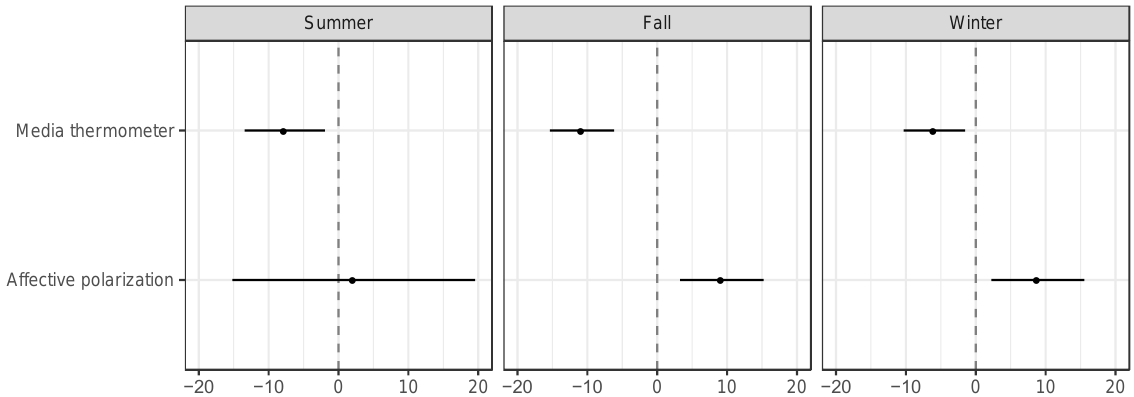
Figure 1b. Association between untrustworthy website consumption and media/party attitudes: Media feelings and affective polarization. Change in media thermometer rating and affective polarization associated with consumption to untrustworthy websites. Point estimates (with 95% confidence intervals) from separate OLS regressions. Outcome measures are respondent feelings toward the media on a 0 – 100 scale (media thermometer) and the difference in feelings respondents express toward their preferred party and the opposition party (both measured on a 0 – 100 scale). Control variables include partisanship, ideology, political knowledge, feelings toward President Trump, age, race, and college education. See Tables B1 and B2 in